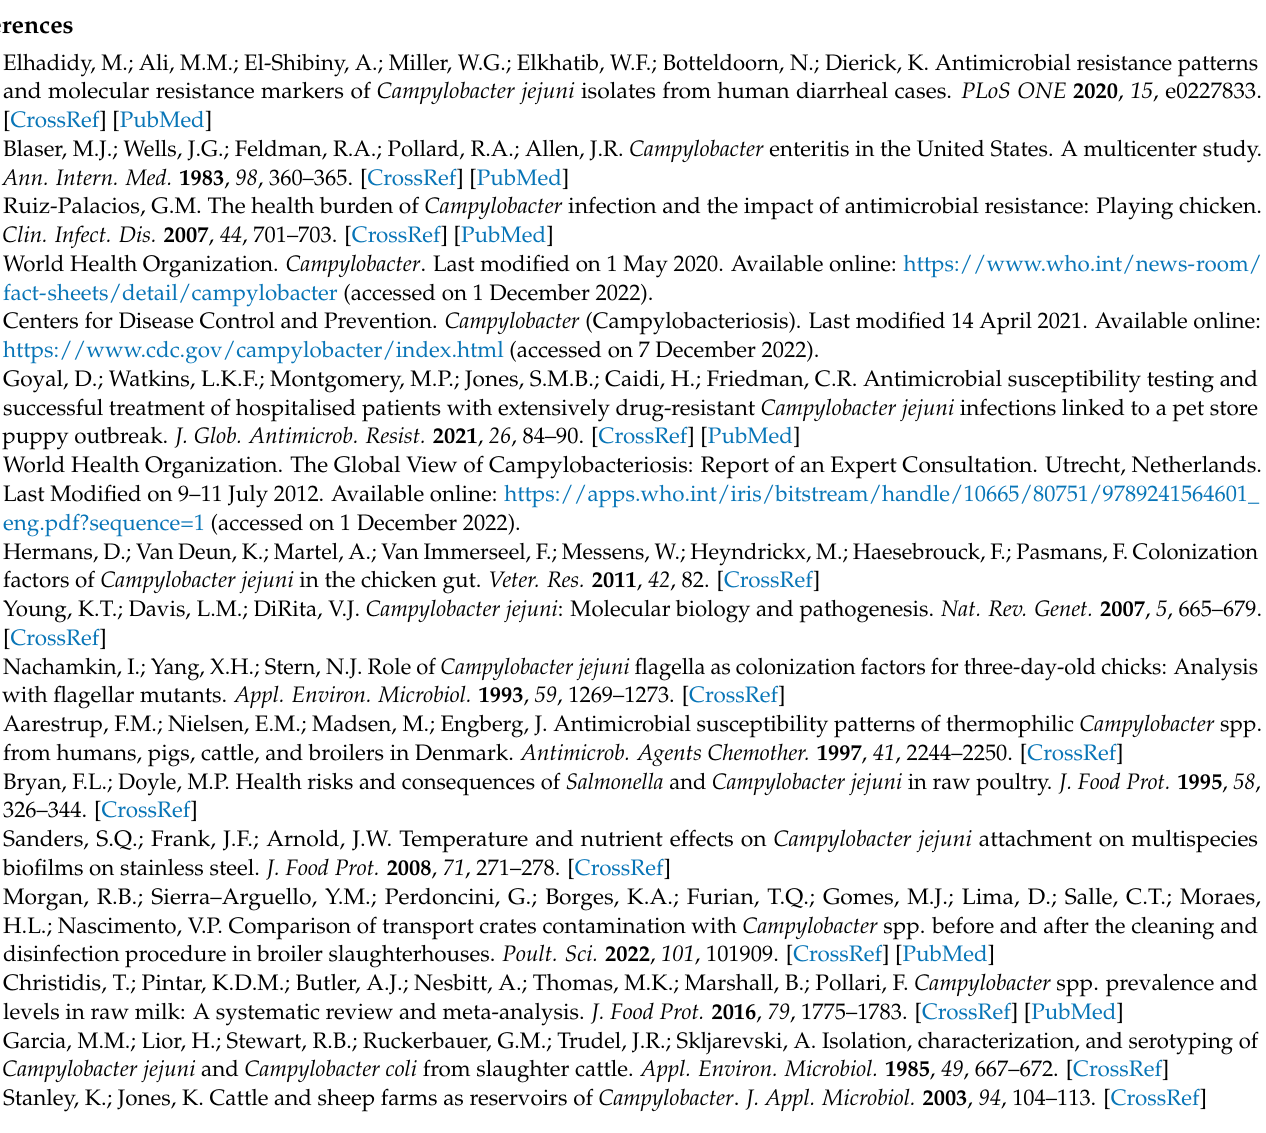
SIEVE algorithm; Table S1: Campylobacter and Salmonella flagellar proteins; Table S2: C. jejuni type III Table S3: Components of the type IV secretion system in C. jejuni ; Table S4: Components of the type VI secretion system in C. jejuni